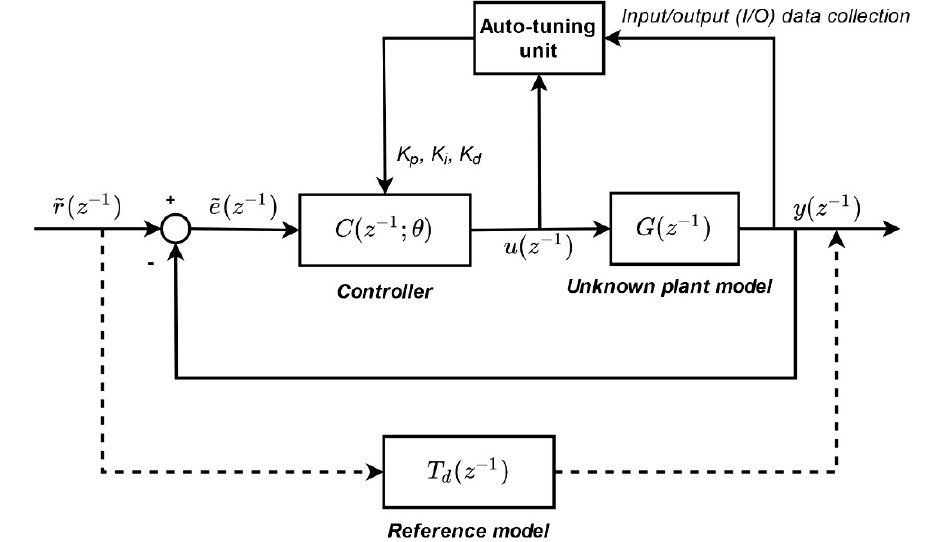
Figure 4. Block diagram of the adaptive controller with an autotuning unit.